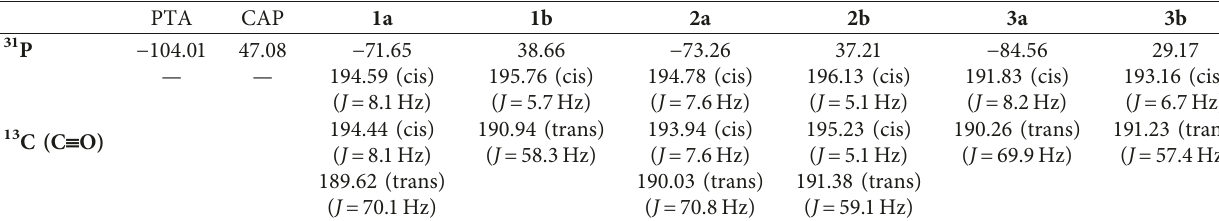
Table 2: 31 P and 13 C (C ≡ O) NMR chemical shifts for PTA, CAP and all Re complexes a .